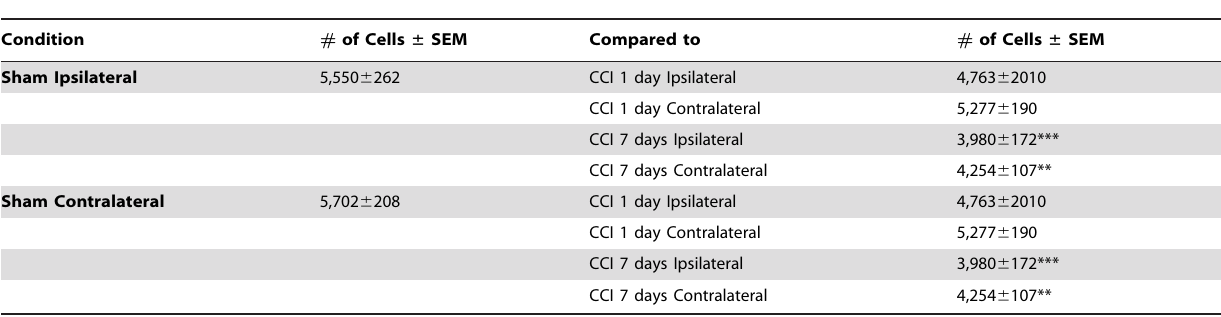
Table 2. Total Number of Interneurons.